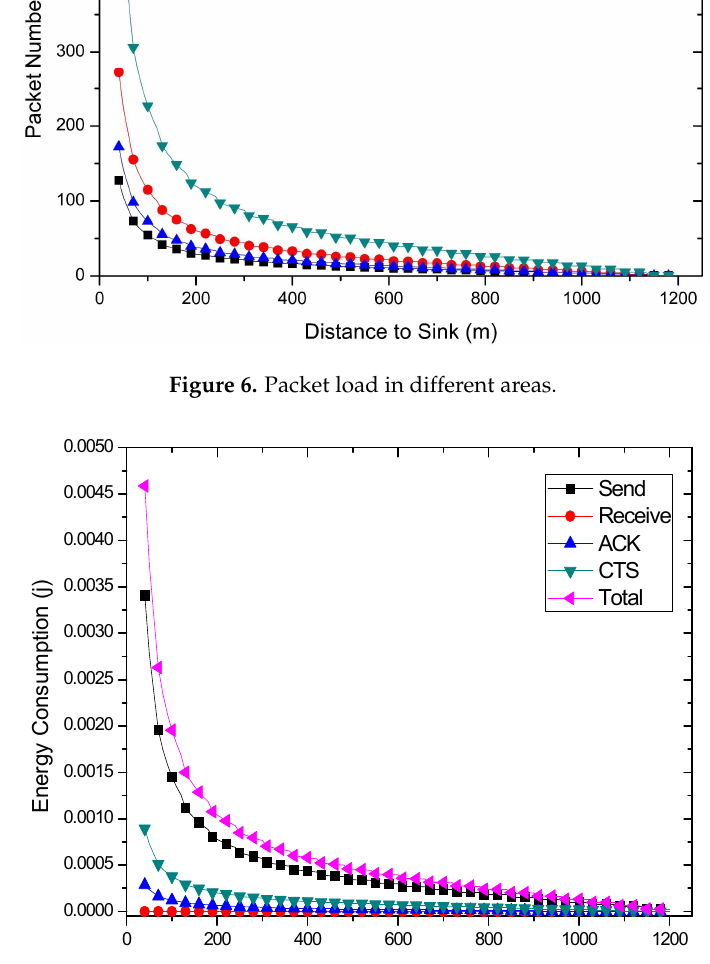
Figure 7. Energy consumption in different areas.